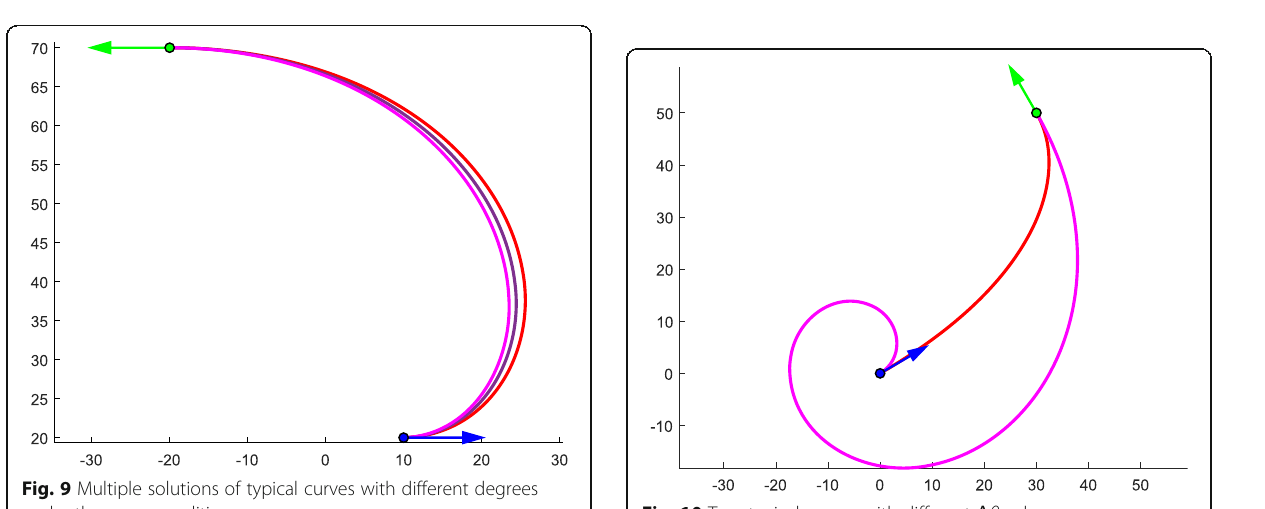
Fig. 10 Two typical curves with different Δ θ